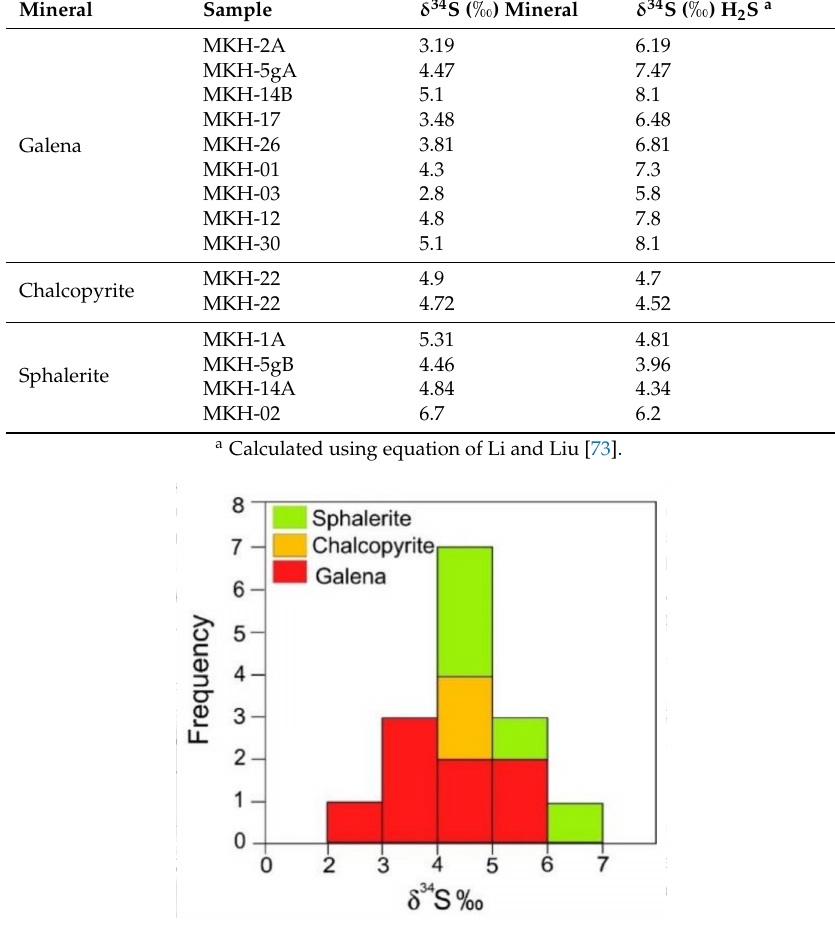
Figure 21. Histograms illustrating the range of sulfur isotope values for sulfides from the Shah-Ali-Beiglou deposit.